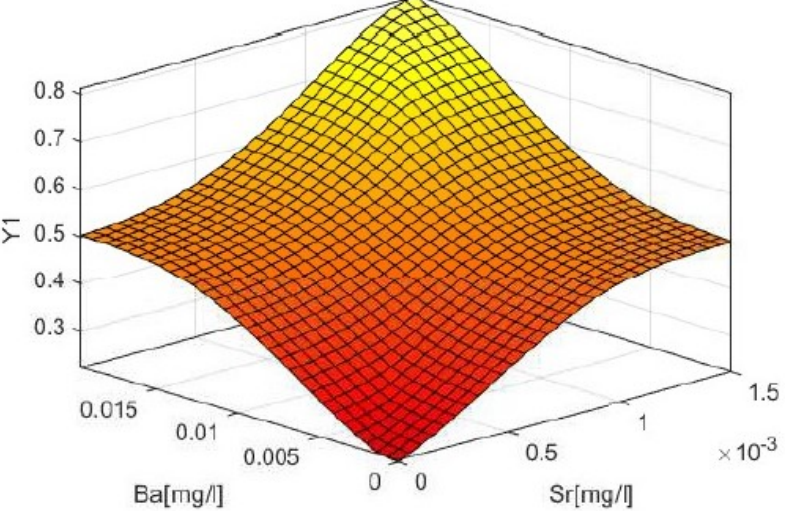
Figure 17. The plane–form relationship for the response of the output variable Y1 to the input variables (leachability of Sr and Ba after 6 h).